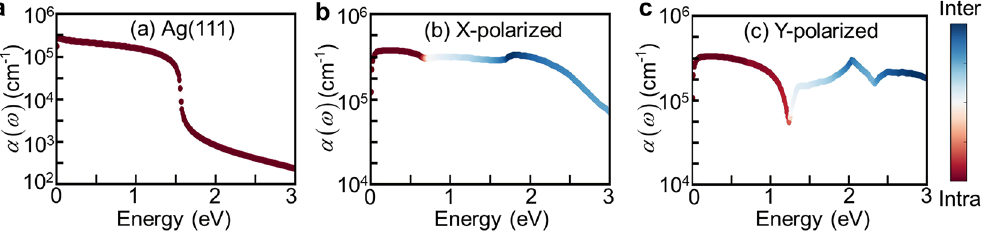
Figure 6: Comparison of direct interband and phonon-assisted intraband electronic transition contributions to hot carrier generations in Ag(111) monolayer (a) and borophene monolayer for X -polarized light (b) and Y -polarized light (c). The vertical axis indicates the optical absorption coef fi cients as a function of photon energy. The color scale incidents the relative contributions of direct interband (blue) and phonon-assisted intraband (red) electronic transitions for hot-carrier generations, which is de fi ned as the ratio of the imaginary part of the dielectric function between the interband and phonon-assisted intraband